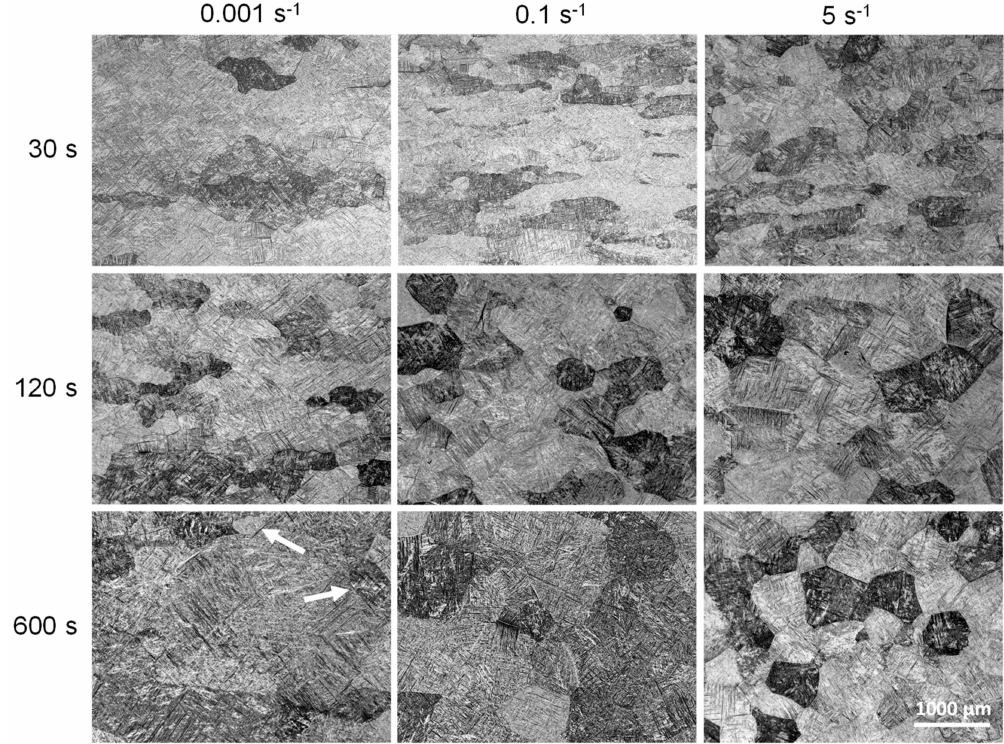
Figure 7. LOM images of samples deformed at 1030 ◦ C and 0.001, 0.1, and 5s − 1 , and isothermally heat treated for 30, 120, and 600 s. The load axis is